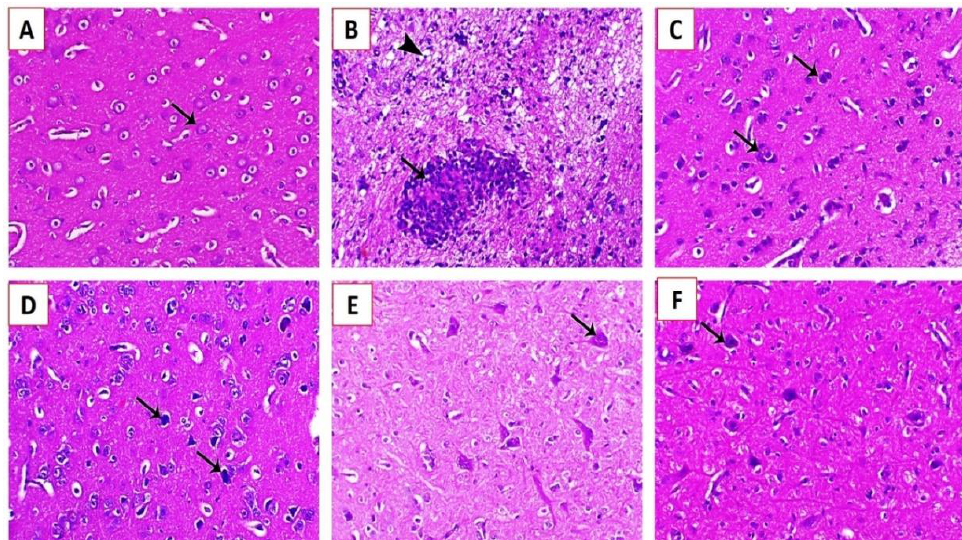
Figure 8. Histopathological lesions in the brains of experimentally infected Cobb chickens 5 dpi: ( A ) brain of the negative control bird (G4) showing normal neuronal cells (arrow); ( B ) brain of an experimentally infected bird in G1 showing spongiosis of the nerve fibers (arrowhead) and focal malacia associated with diffuse and focal conglomerate aggregation of glia cells (arrow); ( C ) brain of an experimentally infected bird in G1 showing gliosis associated with neuronophagia (arrows); ( D ) brain of an experimentally infected bird in G2 showing ischemic neuronal injury (arrows); ( E ) brain of an experimentally infected bird in G3 showing mild to moderate degree of ischemic neuronal injury associated with marked neuronal tigrolysis (arrow); and ( F ) brain of an experimentally infected bird in G3 showing a mild degree of ischemic neuronal injury (arrow) (H&E, X200).